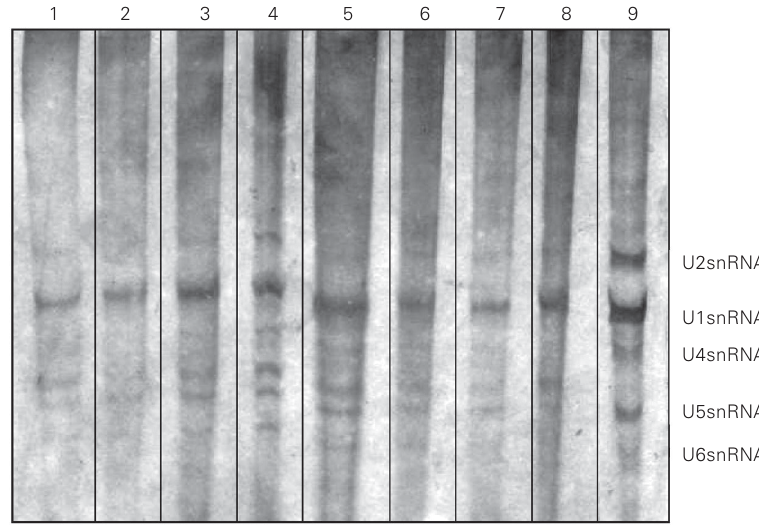
Figure 3. Immunoprecipitation of HeLa nuclear extract by human sera. Human small nuclear RNAs (UsnRNAs) were analyzed in 10% urea/polyacrylamide gel/TBE [1X]. Lane 1 , Normal human serum; lane 2 , cardiac non-chagasic serum; lanes 3 through 8 , chagasic sera; lane 9 , anti-m3G antibody used as positive control to characterize the HeLa